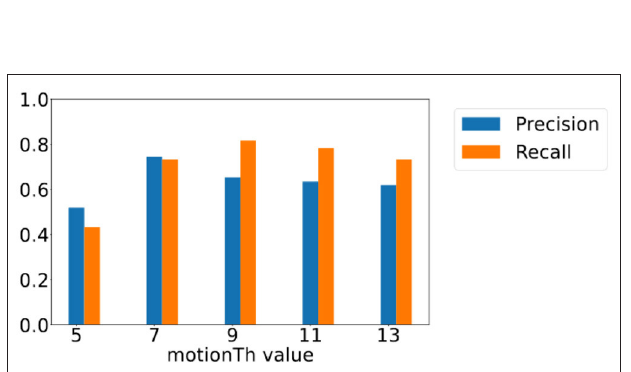
FIGURE 11 | Precision and recall score for footsteps farther than 8 ft away from camera with different motionTh values.